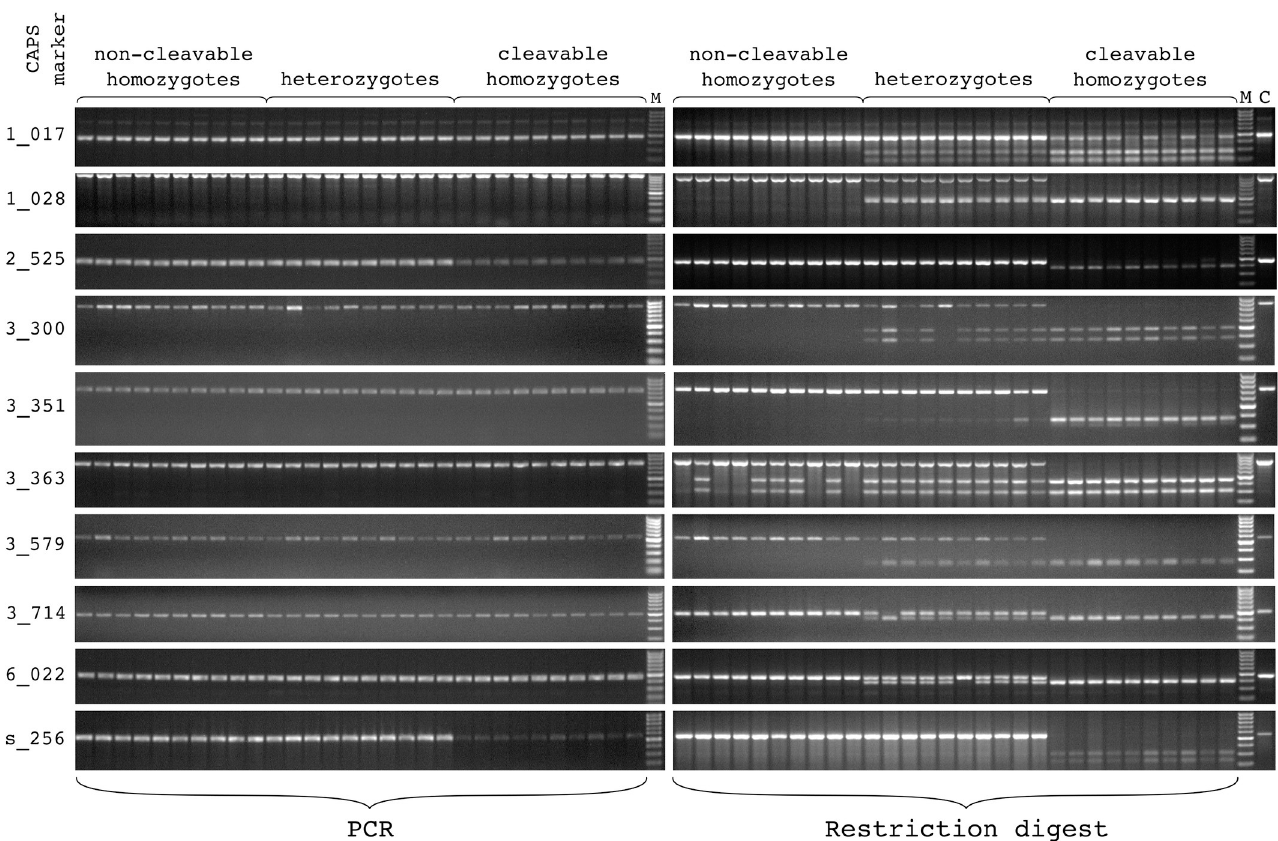
Fig 8. Experimental verification of CAPS markers identified with VCF2CAPS. Analyzed plants originated from population 398 of table beet, and with the program (for a given marker) they were classified as non-cleavable homozygotes, heterozygotes and cleavable homozygotes. Left panel–PCR products, right panel–restriction products (gel regions with some shortest restriction fragments were cropped out of the pictures). In comparison to the previous text and Fig 7 (linkage map) the marker names are abbreviated–only three last digits of the nucleotide position are preserved (Table 1). M–DNA size marker, C–non-digested